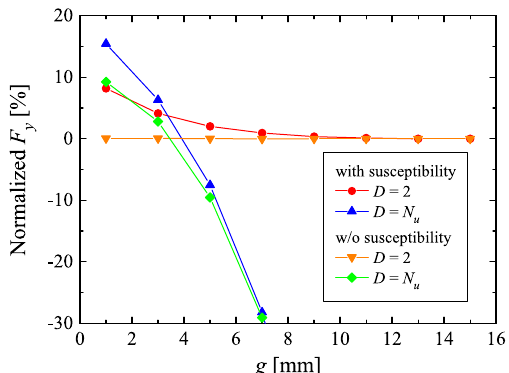
FIG. 7. Numerically calculated magnetic forces for the PCU ( D ¼ 2 ) and the PCU ( D ¼ N ), with and without magnetic u susceptibility. The magnetic forces at the respective gap values are normalized by those for